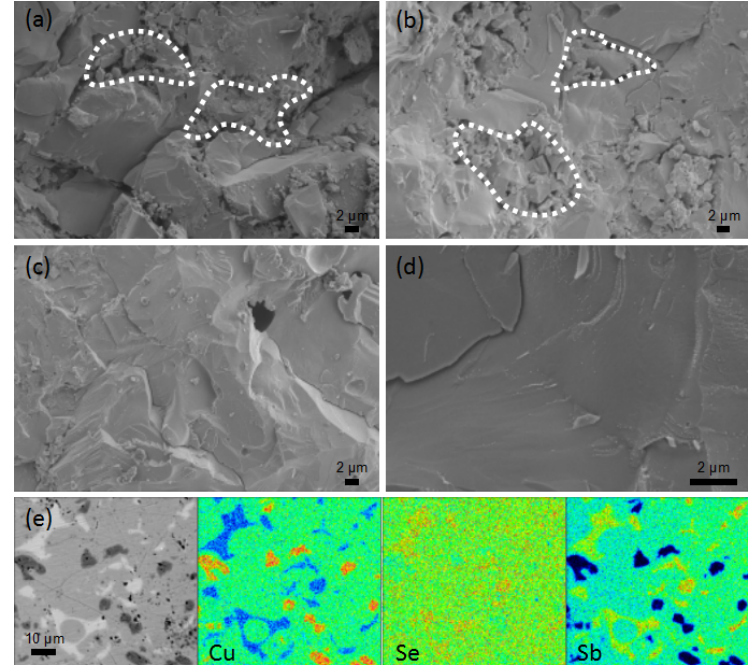
Figure 2. Scanning electron microscopy (SEM) images of ( a ) spark plasma sintering (SPS) 593, ( b ) SPS 613, ( c ) SPS 633 and ( d ) SPS 653 bulk samples; and ( e ) electron probe micro-analyzer (EPMA) images of SPS 633 bulk sample.